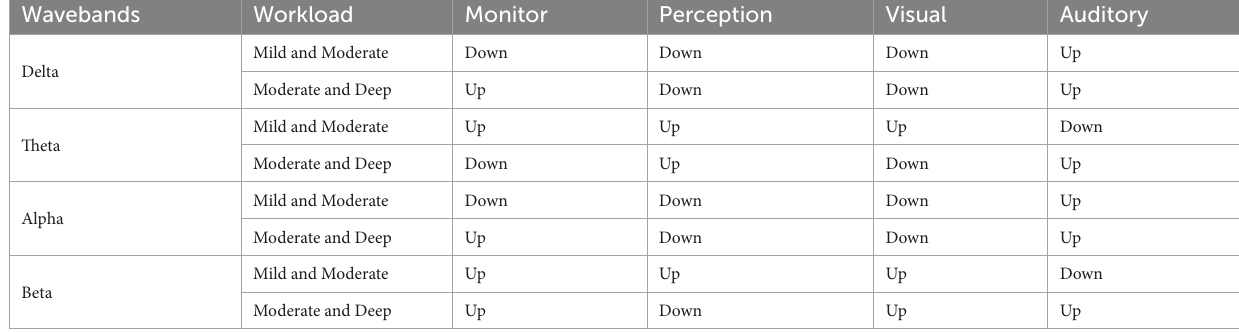
TABLE 3 Changing trend of the occupancy of each channel under different cognitive